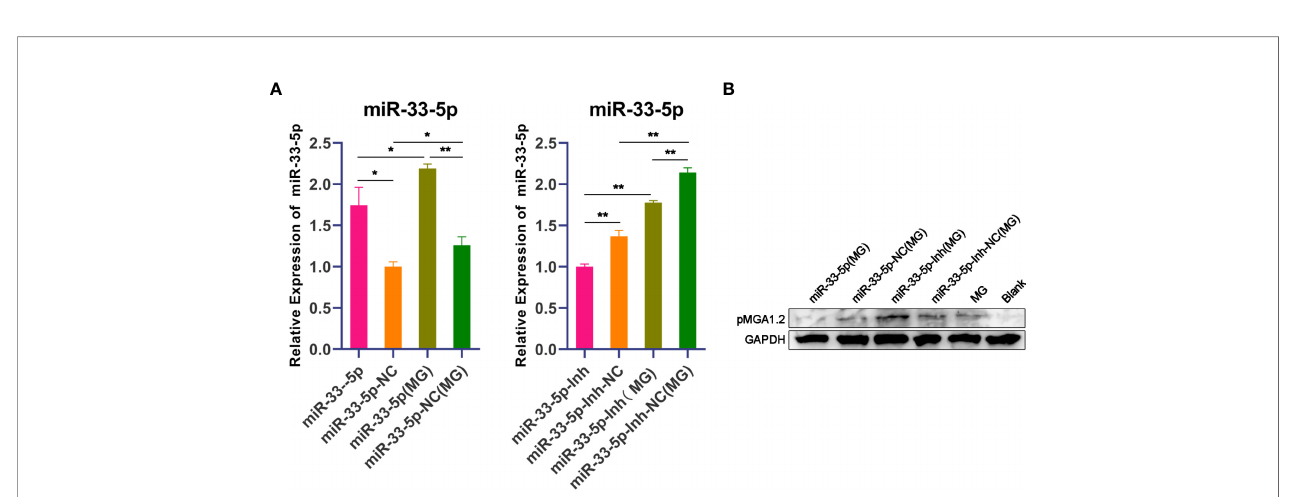
FIGURE 2 | miR-33-5p inhibits pMGA1.2 expression in DF-1 cells. DF-1 cells were transfected with miR-33-5p, miR-33-5p-NC, miR-33-5p-Inh or miR-33-5p-Inh- NC and were incubated for 24h and then infected MG for 24h. (A) qPCR was used to detect the expression of miR-33-5p, 5s-RNA was used as the internal control; (B) Western blot was used to detect the adhesion protein pMGA1.2 of MG. GAPDH was used as the internal control. (* p < 0.05, ** p <